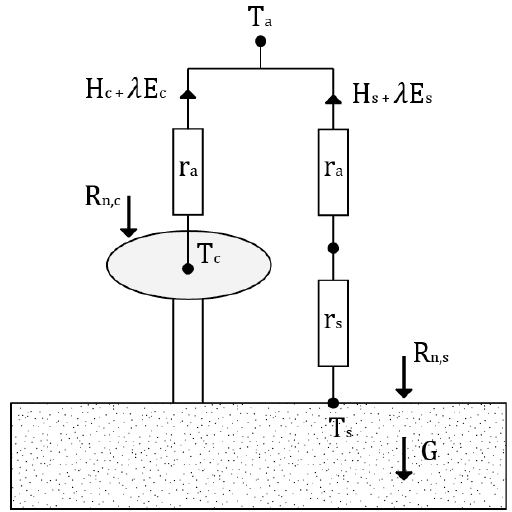
Fig. 1. Scheme of the resistance network of TSEB following Norman et al.